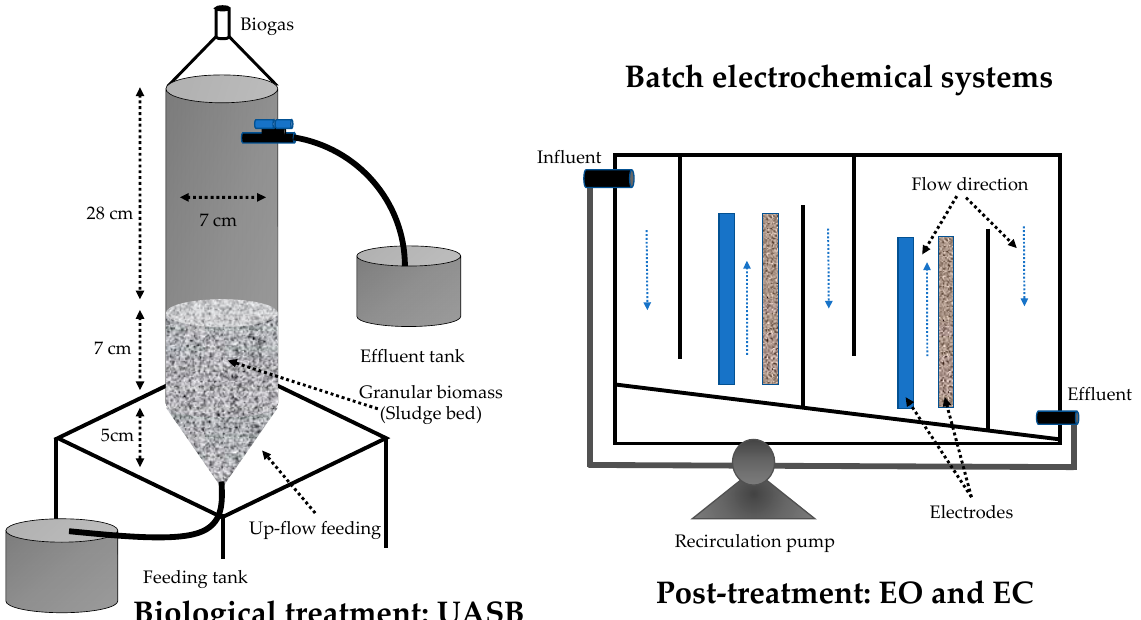
Figure 1. Scheme of systems used for CR elimination. The left anaerobic reactor operated continuously and in the proper flow direction in the electrochemical cells operated in batch.